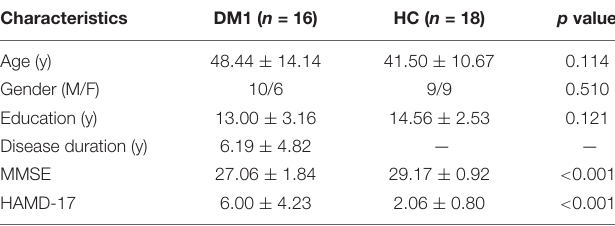
TABLE 1 | Demographics and clinical characteristics of the subjects.